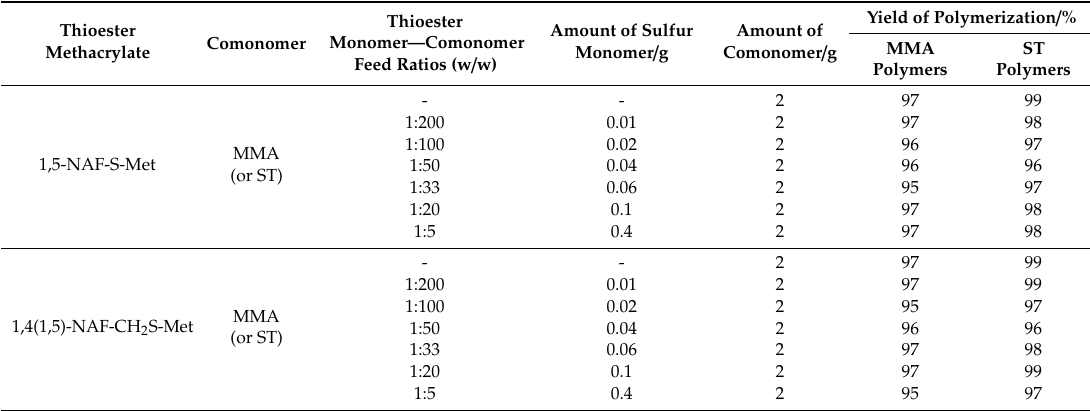
Table 1. The amounts of monomers used in copolymerization.